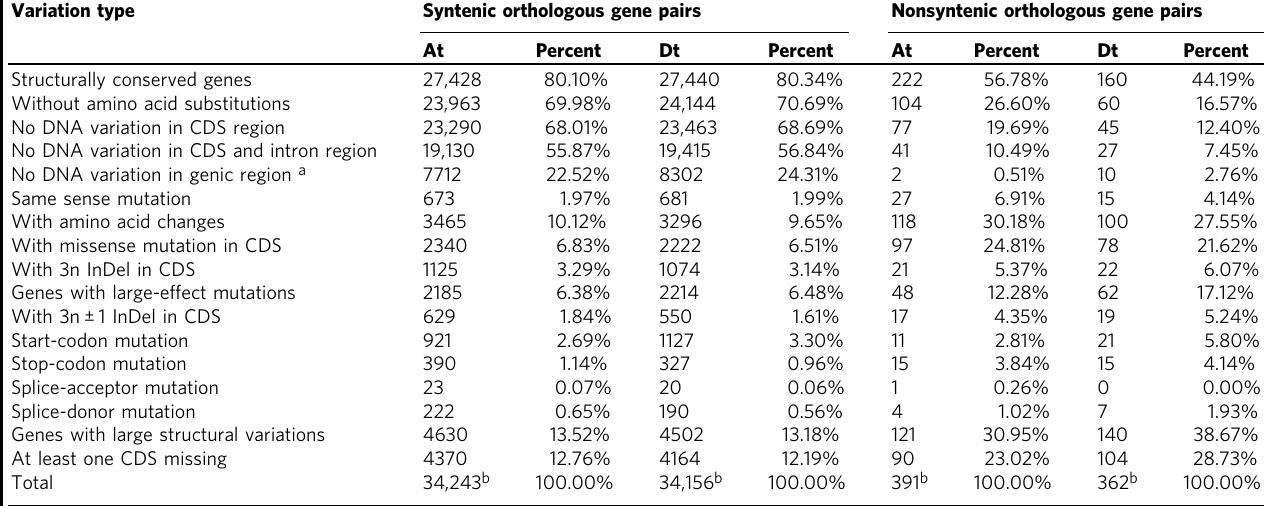
Table 2 Variations within genes between TM-1 and ZM24